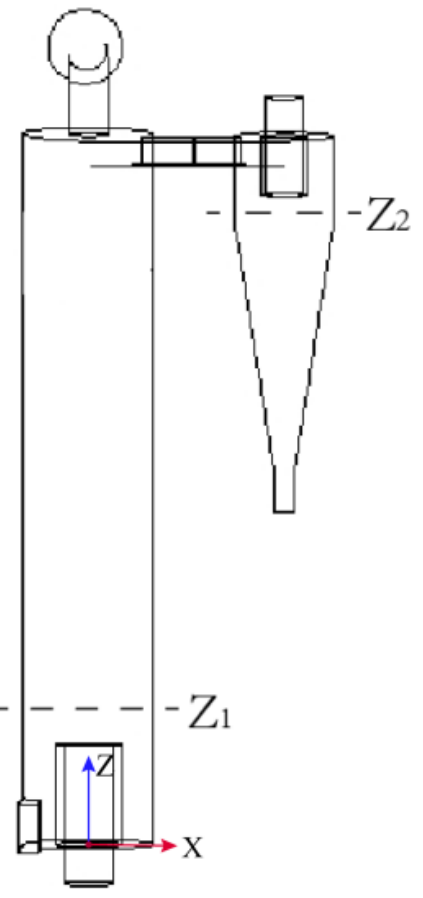
Figure 2. Location of feature lines.